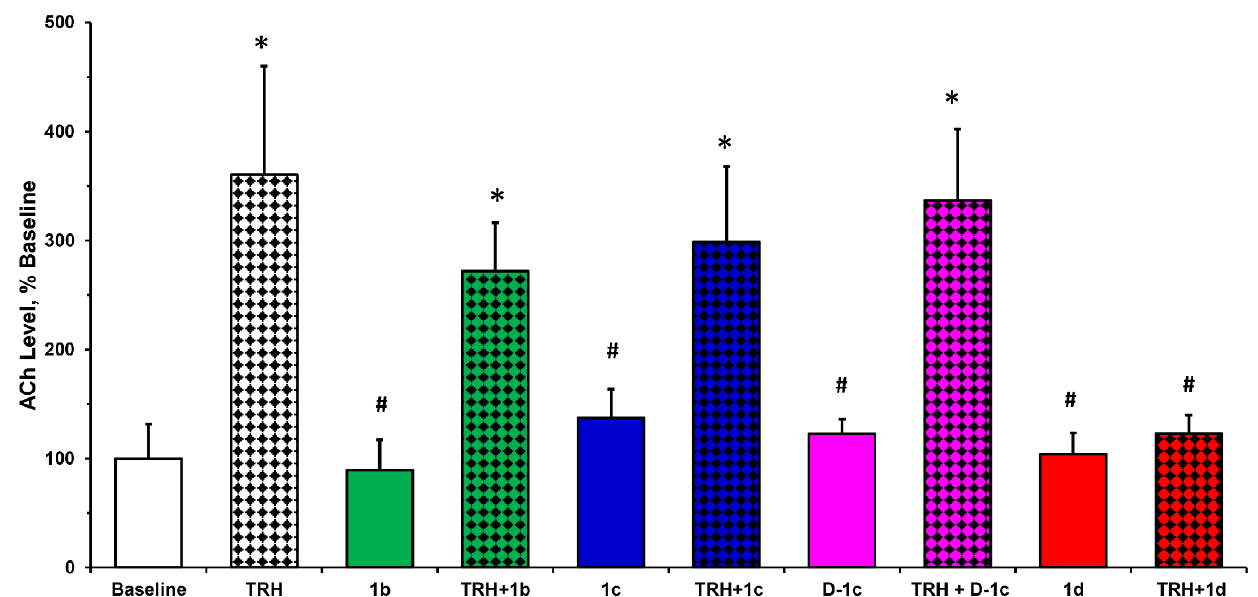
Figure 4. Percent changes in hippocampal ACh levels upon perfusing test agents alone or together with an equimolar concentration of TRH (3 µ M, each in aCSF containing 2 µ M neostigmine). The steady-state baseline ACh level was measured in the microdialysates collected for 2 h in 20-min fractions after 1 h of the initiation of the experiment. Then, perfusion was switched to a solution containing TRH and/or the test agent dissolved in aCSF containing 2 µ M neostigmine. ACh levels after the test agents ’ perfusions were expressed as percent changes in 3– 6 fractions after equilibration compared with the steady state baseline ACh levels taken as 100%. ANOVA followed by post hoc Tukey ’s tests ( p < 0.05, n = 4): * indicates statistically significant difference from baseline control, # indicates statistically significant difference from TRH alone.